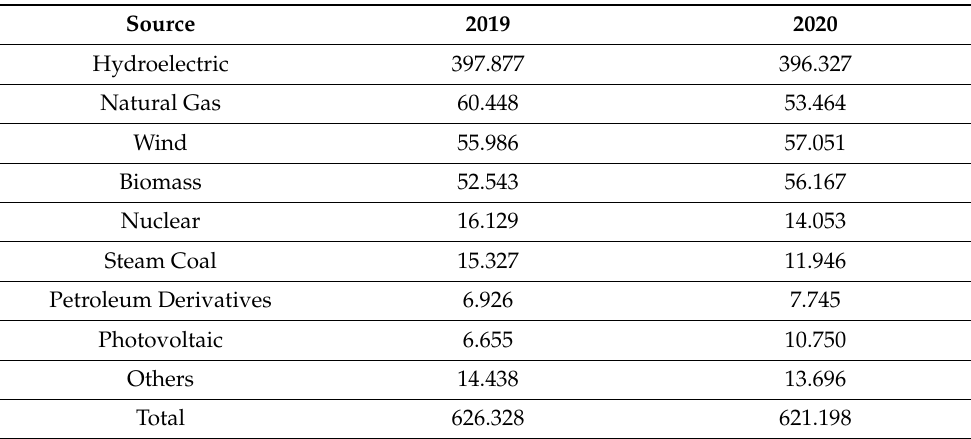
Table 2. Energy consumption by source of the Brazilian electrical mix in 2019 and 2020